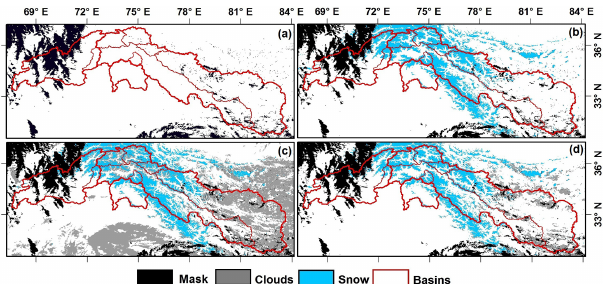
Figure 5. Spatial illustration of the cloud removal technique valida- tion over the Aqua snow image with respect to the Terra snow image for day 96 of the year 2004 over the whole AOI (Terra cloud mask in black, snow cover in blue, and the Aqua cloud cover is shown in grey). (a) Terra cloud cover, (b) Terra snow image after masking out the Terra cloud cover, (c) Aqua snow image after masking out the Terra cloud cover, (d) Aqua snow image after applying all cloud removal steps, except for combining it with the Terra same-day im- age.